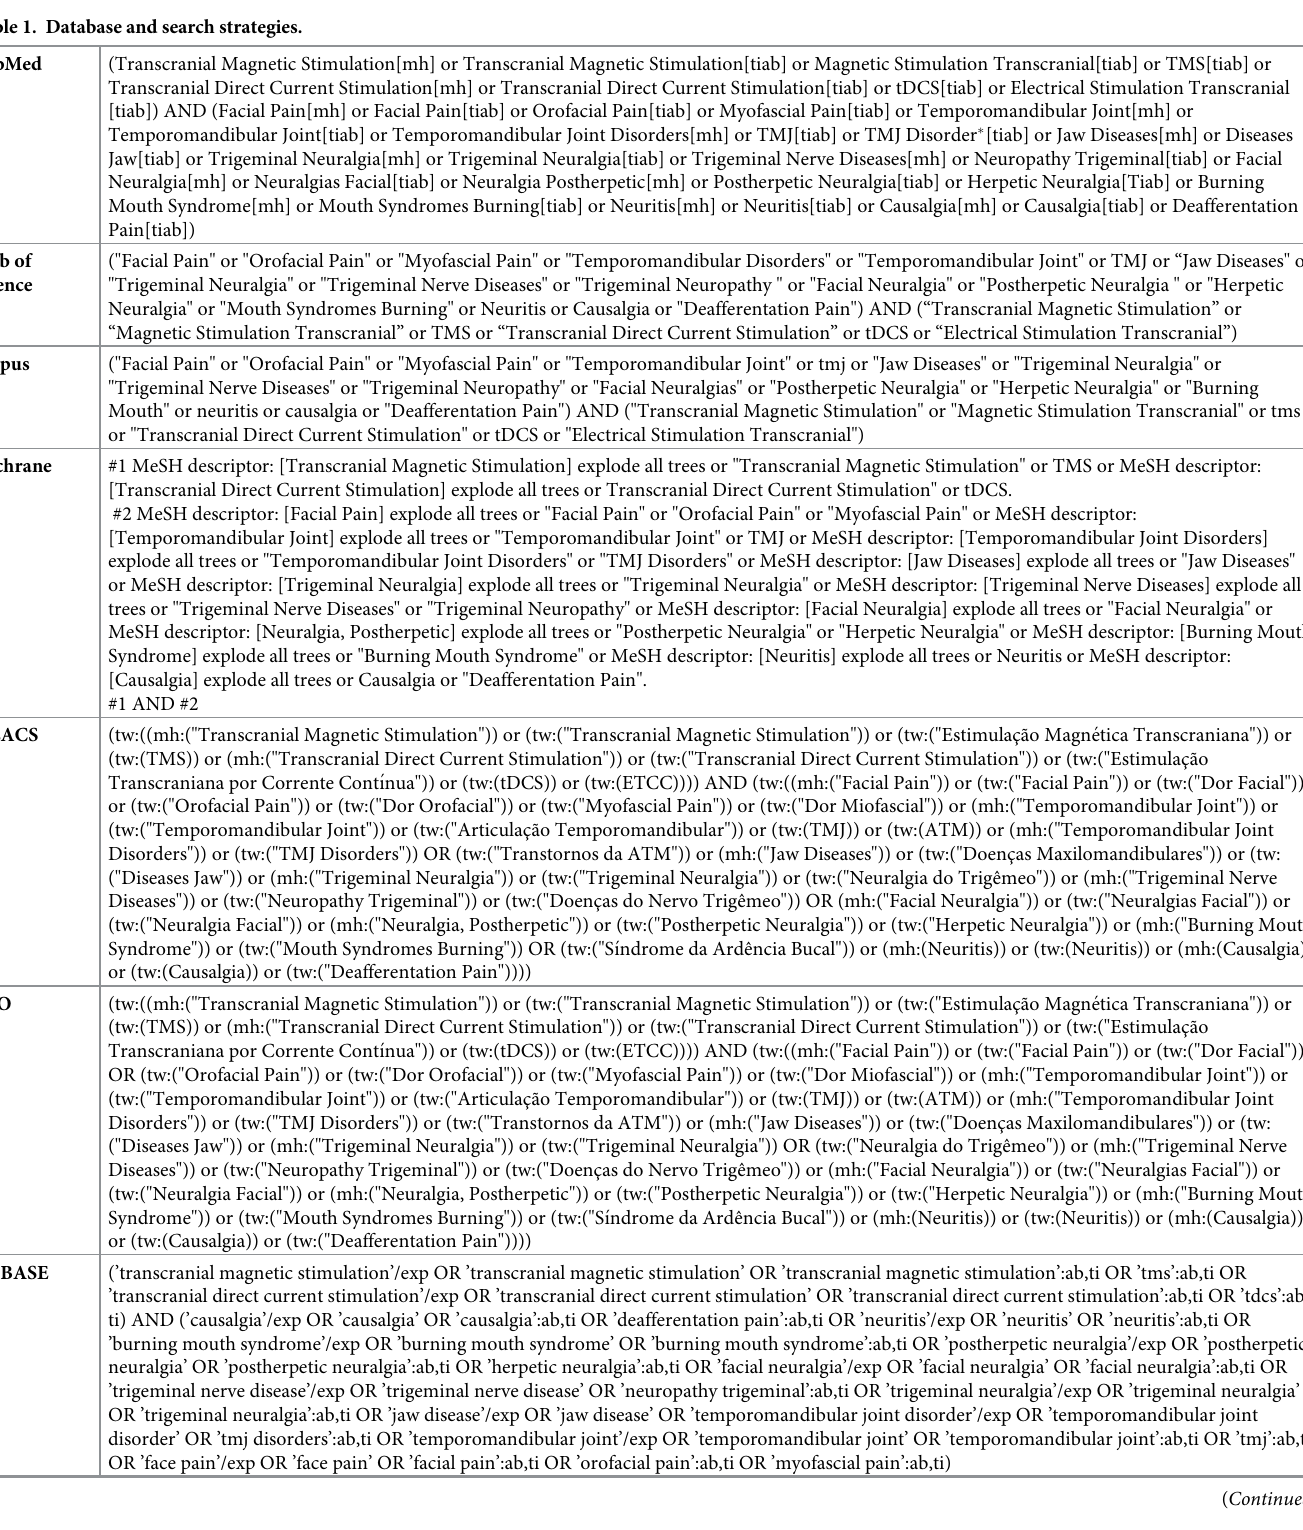
Table 1. Database and search strategies.